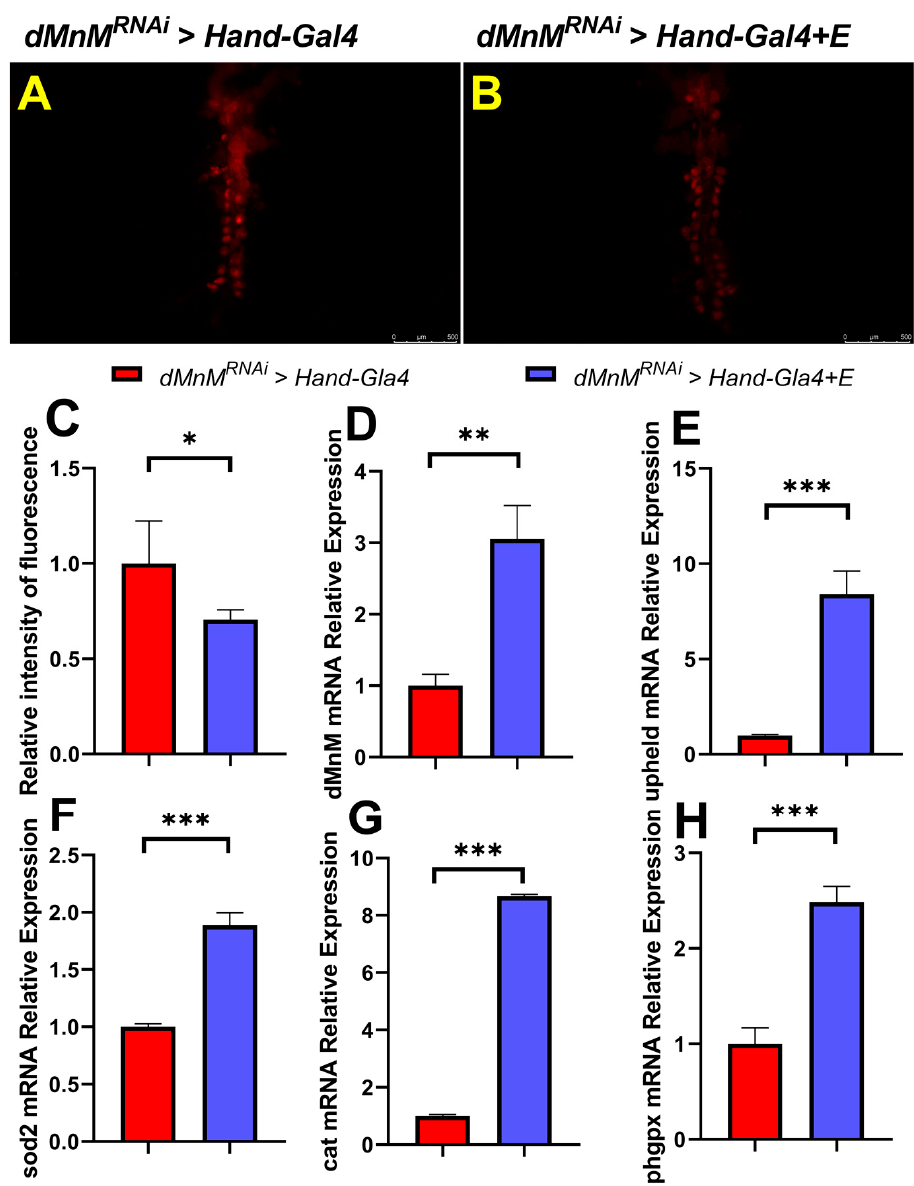
Figure 7. Effects of regular exercise on ROS produced by specific knockdown of cardiac dMnM and mRNA expression levels of dMnM, upheld, phgpx, sod2, and cat. ( A , B ) DHE-stained images of hearts in the dMnM RNAi > Hand-Gal4 group and dMnM RNAi > Hand-Gal4 + E group, respectively; n = 5. ( C ) Relative fluorescence intensity of the heart. ( D – H ) Relative expression levels of dMnM, upheld, sod2, cat, and phgpx mRNA; n = 30. An independent-samples t -test was used to assess differences between the two groups, * p < 0.05, ** p < 0.01, *** p < 0.001.